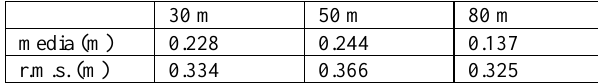
Table 6. Statistical results of trees+vines